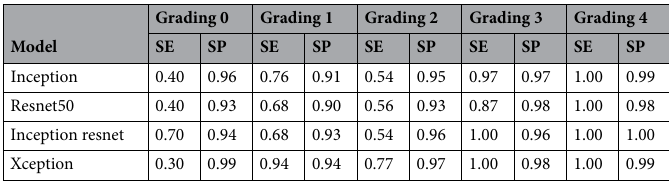
Table 2. Sensitivity (SE) and specificity (SP) for each of the